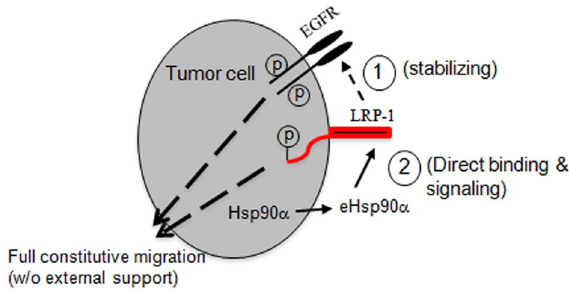
Figure 7. A working model for LRP-1-coordinated mechanism for constitutive motility of MDA-MB-231 tumour cells. Migration and invasion of different tumours are likely driven under distinct tumour driver genes. Therefore, the current finding represents a mechanism that regulates the constitutive motility of certain tumour